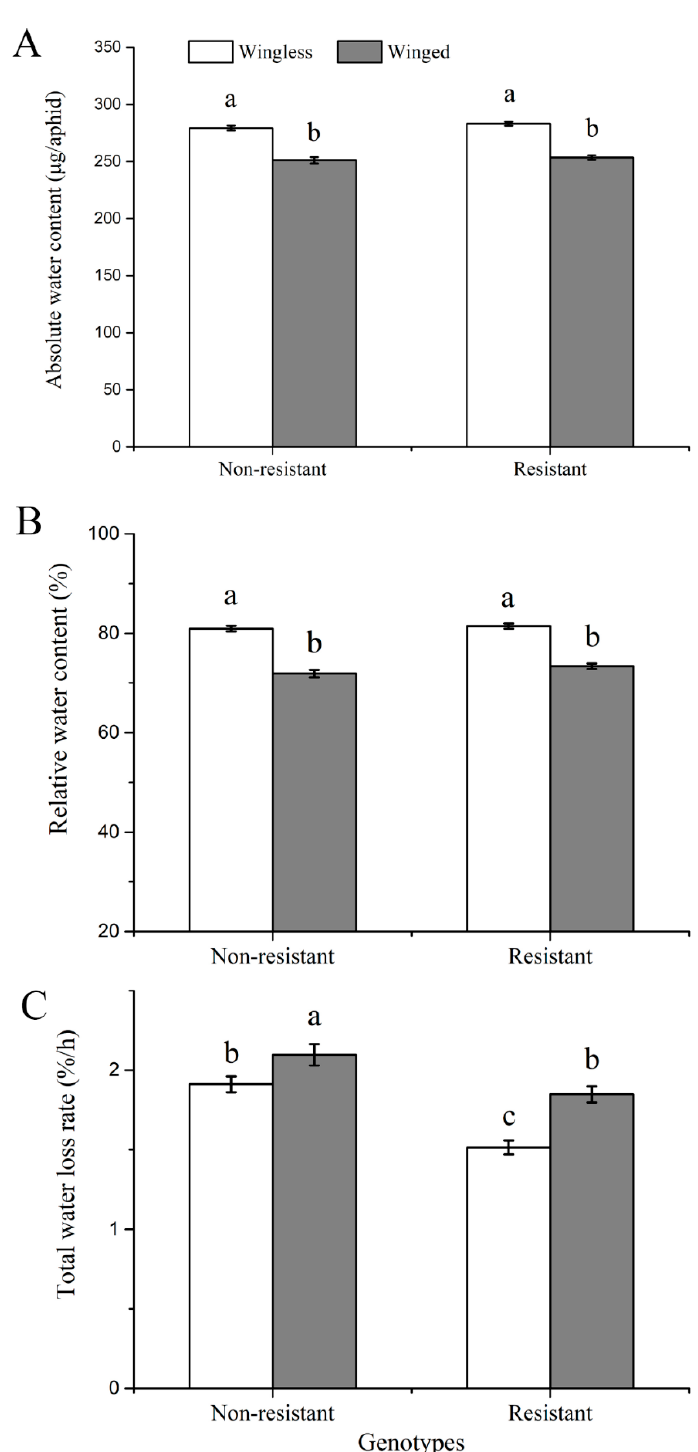
Figure 3. Comparisons of water balance traits (mean ± SE) between nonresistant and resistant genotypes for winged and wingless Sitobion avenae : ( A ) absolute water content; ( B ) relative water content; ( C ) water loss rate per hour. Di ff erent letters above bars indicate significant di ff erences between